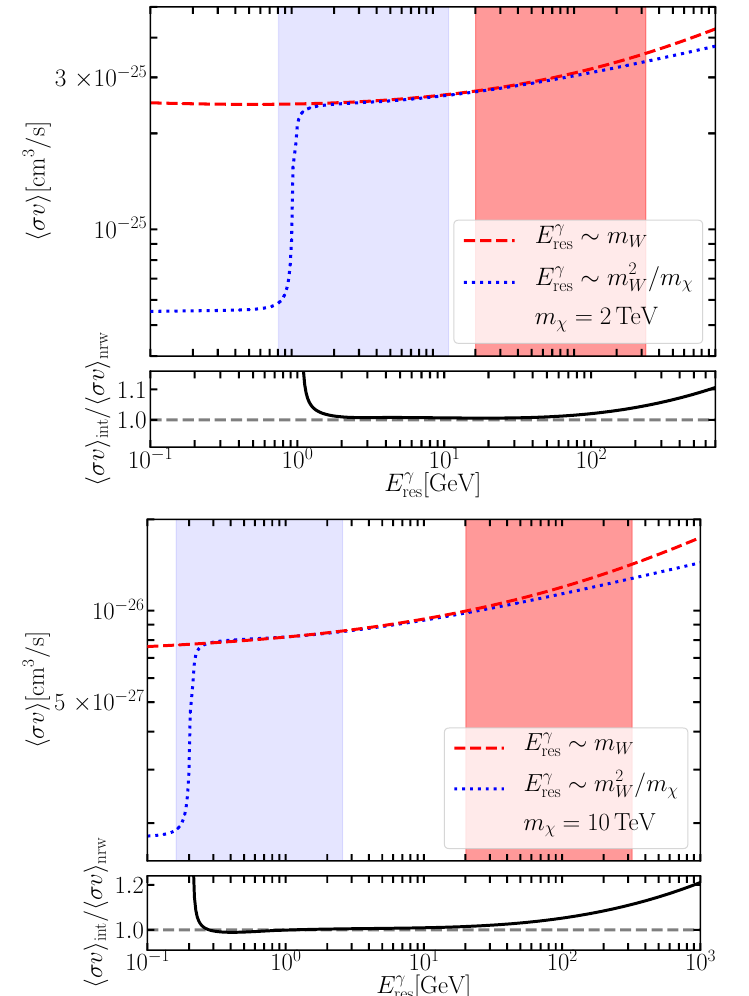
. The blue-dotted line shows the res